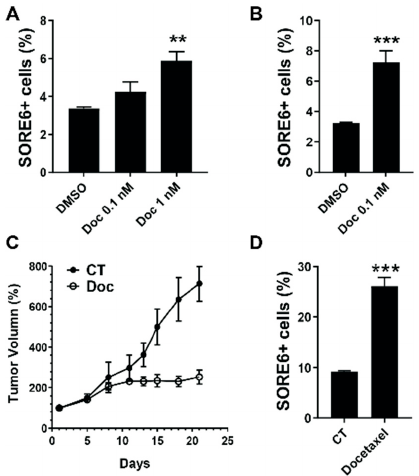
Figure 3 . SORE6 + cells are relatively resistant to Docetaxel. ( A , B ) The effect of the docetaxel (Doc) treatment for 3 days, on the SORE6 + fraction in ( A ) PC3 and ( B ) DU145 cells. **, *** p < 0.01 and 0.001 versus DMSO, respectively, n = 3. ( C , D ) The effect of the docetaxel treatment on ( C ) primary tumor growth and ( D ) the SORE6 + fraction in the tumor. Nude mice ( n = 6) were subcutaneously implanted with PC3 cells and treated with vehicle (CT) or docetaxel (15 mg/kg, i.p. once per week) for 3 weeks, once tumors reached the size of ~200–300 mm 3 . The tumor growth was measured by caliper and expressed as percentage changes of the tumor volume after the docetaxel treatment. One week after the end of the docetaxel treatment, the SORE6 + fraction in the tumor was determined by flow cytometry in live CD31 - CD45 - Ter119 − cells. *** p < 0.001 versus CT, n =